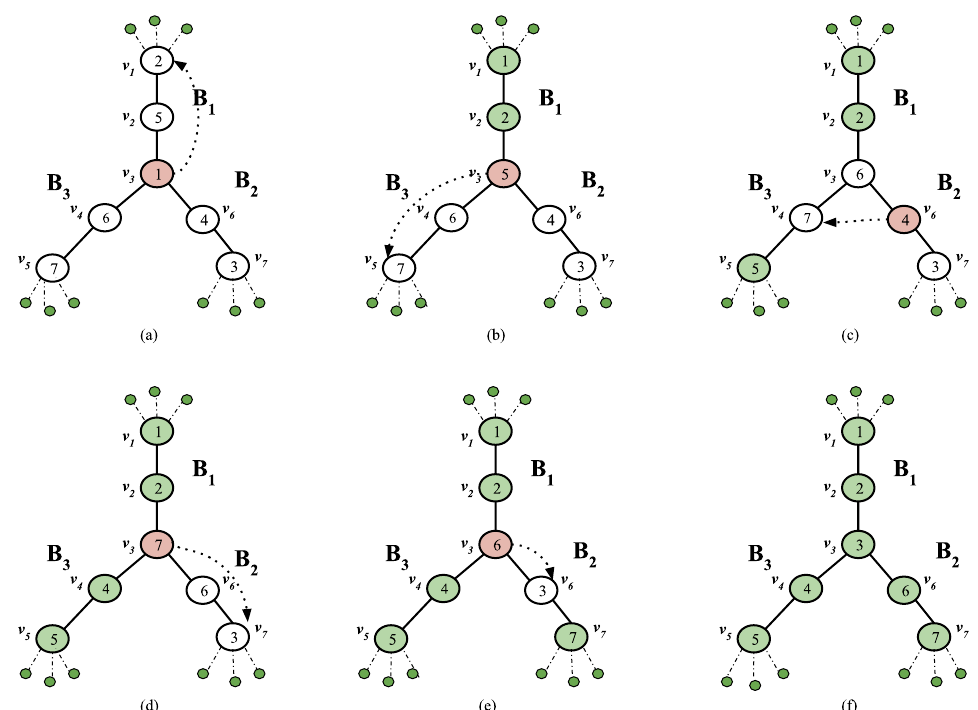
Figure 10. One possible swap sequence of path markers on a 3-Broom shown in ( a ). ( a ) Homing 1, Swaps = 2. ( b ) Homing 5, Swaps = 2. ( c ) Homing 4, Swaps = 2. ( d ) Homing 7, Swaps = 2. ( e ) Homing 6, Swaps = 1. ( f ) All markers are homed. Total Swaps = 9.